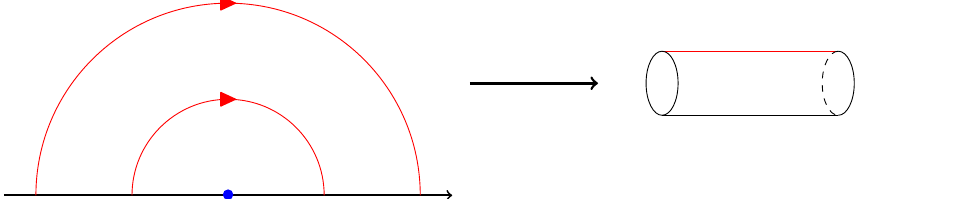
Fig. 10 The Riemann surface obtained by quotienting the upper half- plane by dilatation: ( t , x , y ) ∼ e 2 πκ ( t , x , y ) , as described in Eq. (160). The fundamental domain is bounded by the red semicircles, while the